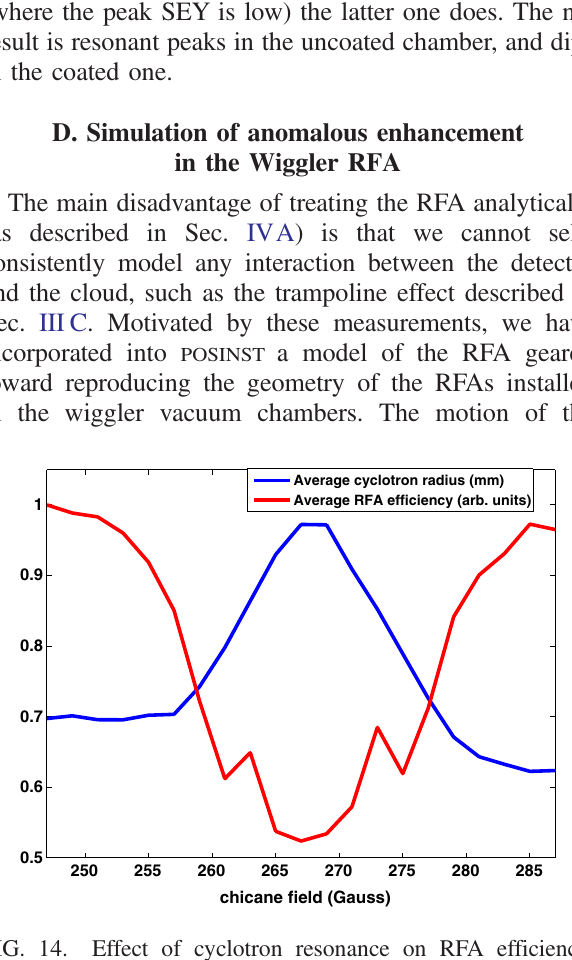
FIG. 14. Effect of cyclotron resonance on RFA efficiency, 1 × 45 × 1 mA e þ , 4 ns, 5 GeV. Under the resonant field, the average electron cyclotron radius increases, resulting in a decrease in the average RFA